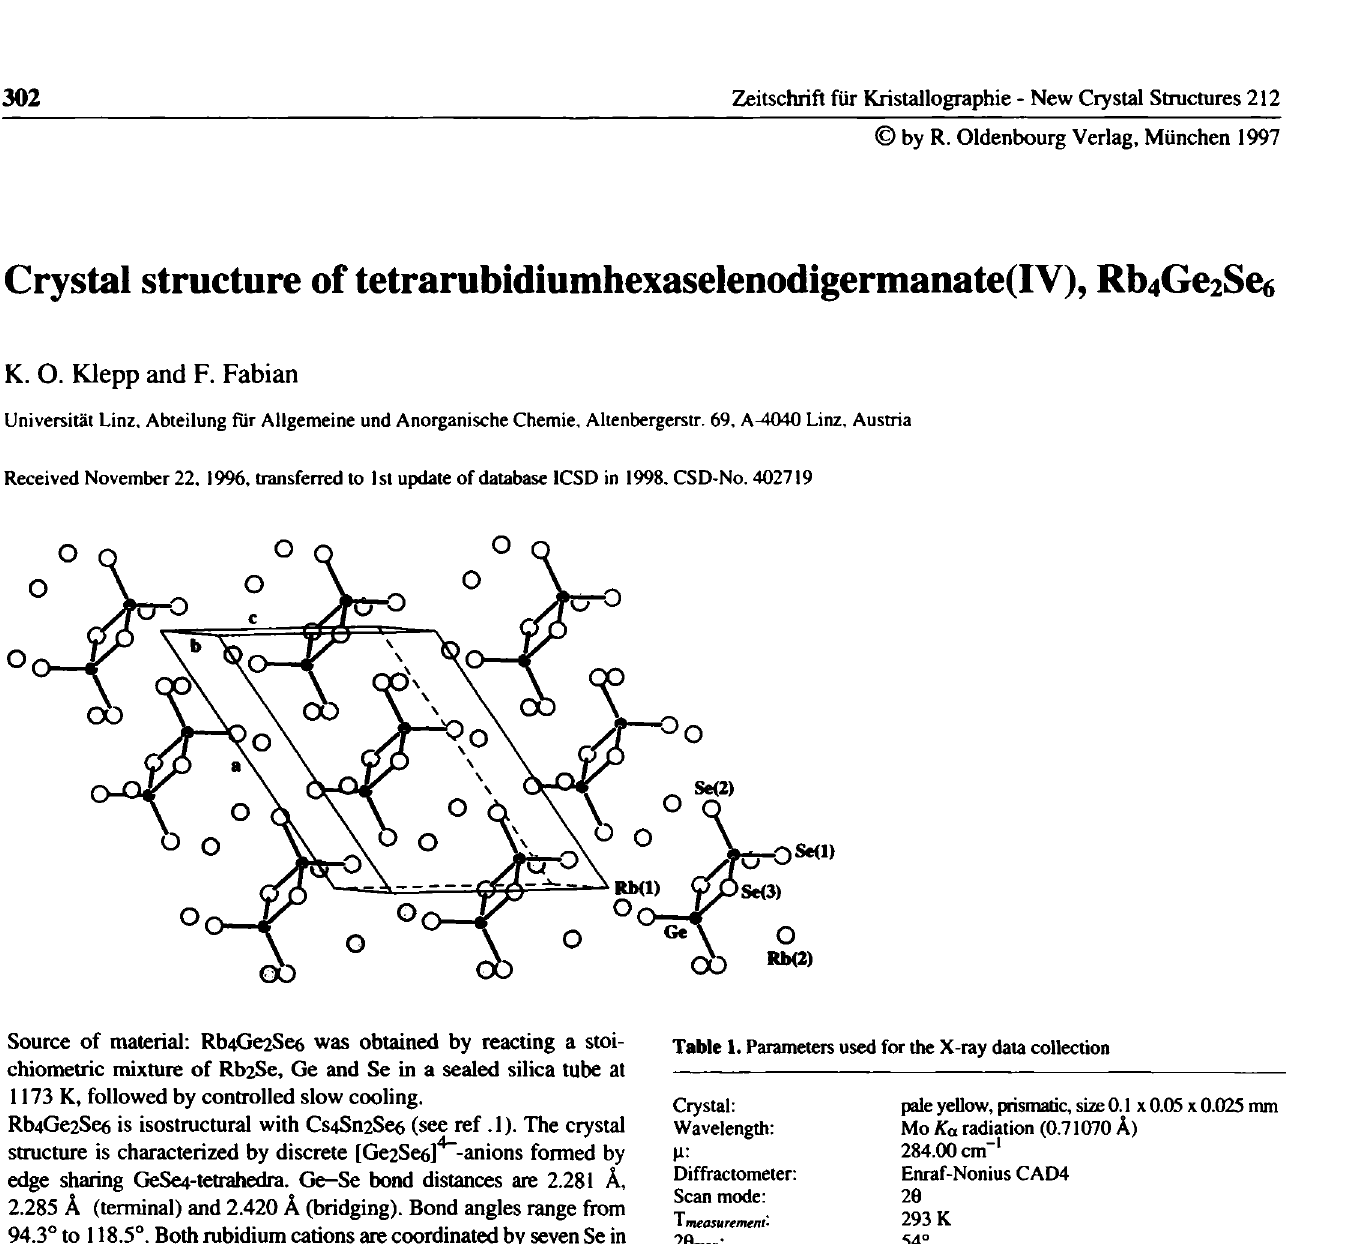
Table 2. Final atomic coordinates and displacement parameters (in Â 2 )